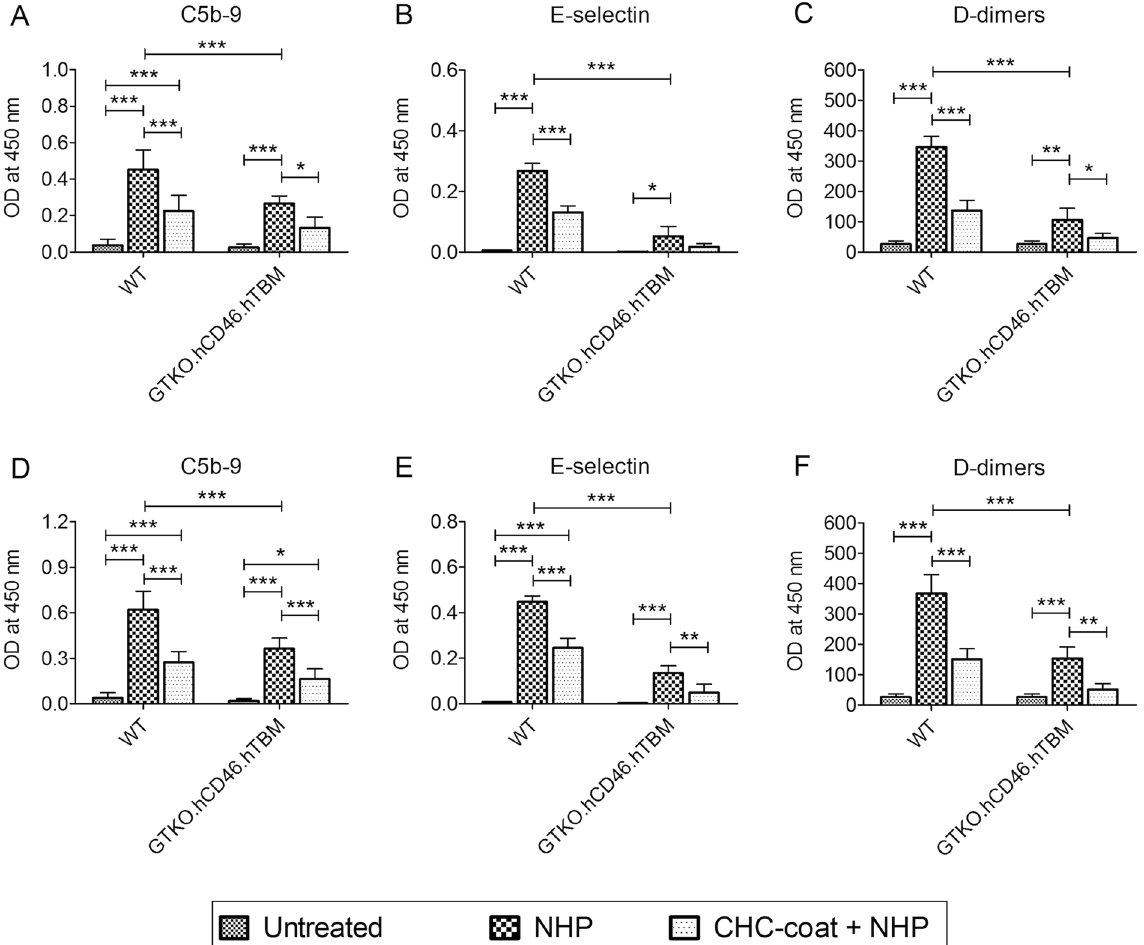
Figure 2. ( A–C ) CHC coating of PAEC reduces complement deposition, cellular activation and coagulation induced by human plasma. Uncoated and CHC-coated PAEC were treated for 4 hrs with 10% human plasma, and assessed by ELISA for ( A ) the deposition of activated complement C5b-9 and ( B ) the expression of the adhesion molecule E-selectin ( B ). ( C ) Supernatants from this assay were measured for D-dimers concentration. CHC coating significantly protected WT PAEC. Uncoated GTKO.hCD46.hTBM PAEC were significantly protected compared to uncoated WT PAEC; coating with CHC further reduced complement deposition and cellular activation, although this was not statistically significant. ( D,F ) CHC coating of hTNF α -activated PAEC reduces complement deposition, cellular activation and coagulation induced by human plasma. WT and GTKO.hCD46.hTBM PAEC were treated with hTNF α (100 ng/ml) for 2 hrs to induce cellular activation and shedding of the endothelial glycocalyx. After, PAEC were coated with CHC and incubated for 4 hrs with 10% human plasma, and assessed for ( D ) complement C5b-9 deposition and ( E ) endothelial E-selectin expression as well as ( F ) D-dimer levels in the supernatants. CHC coating significantly protected hTNF α -activated WT and GTKO.hCD46.hTBM PAEC compared to uncoated PAEC. Significance was measured by one-way ANOVA with Bonferroni correction ( * p < 0.05, ** p < 0.01, *** p < 0.001). Data are mean ± SD of three independent